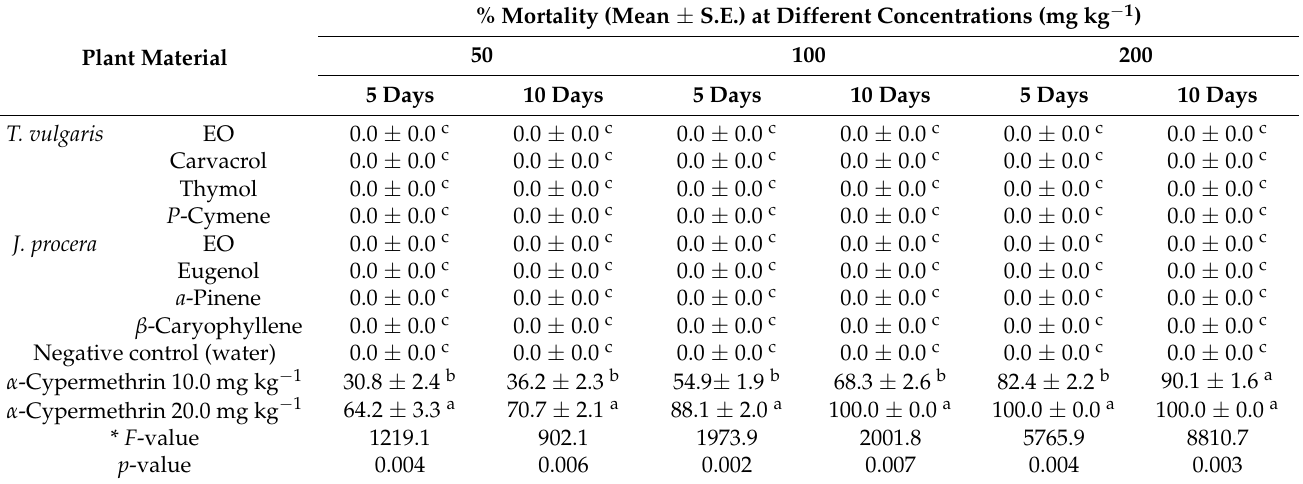
Table 7. * Acute toxicity of plant oils and their main terpenes against the earthworm, Eisenia fetida